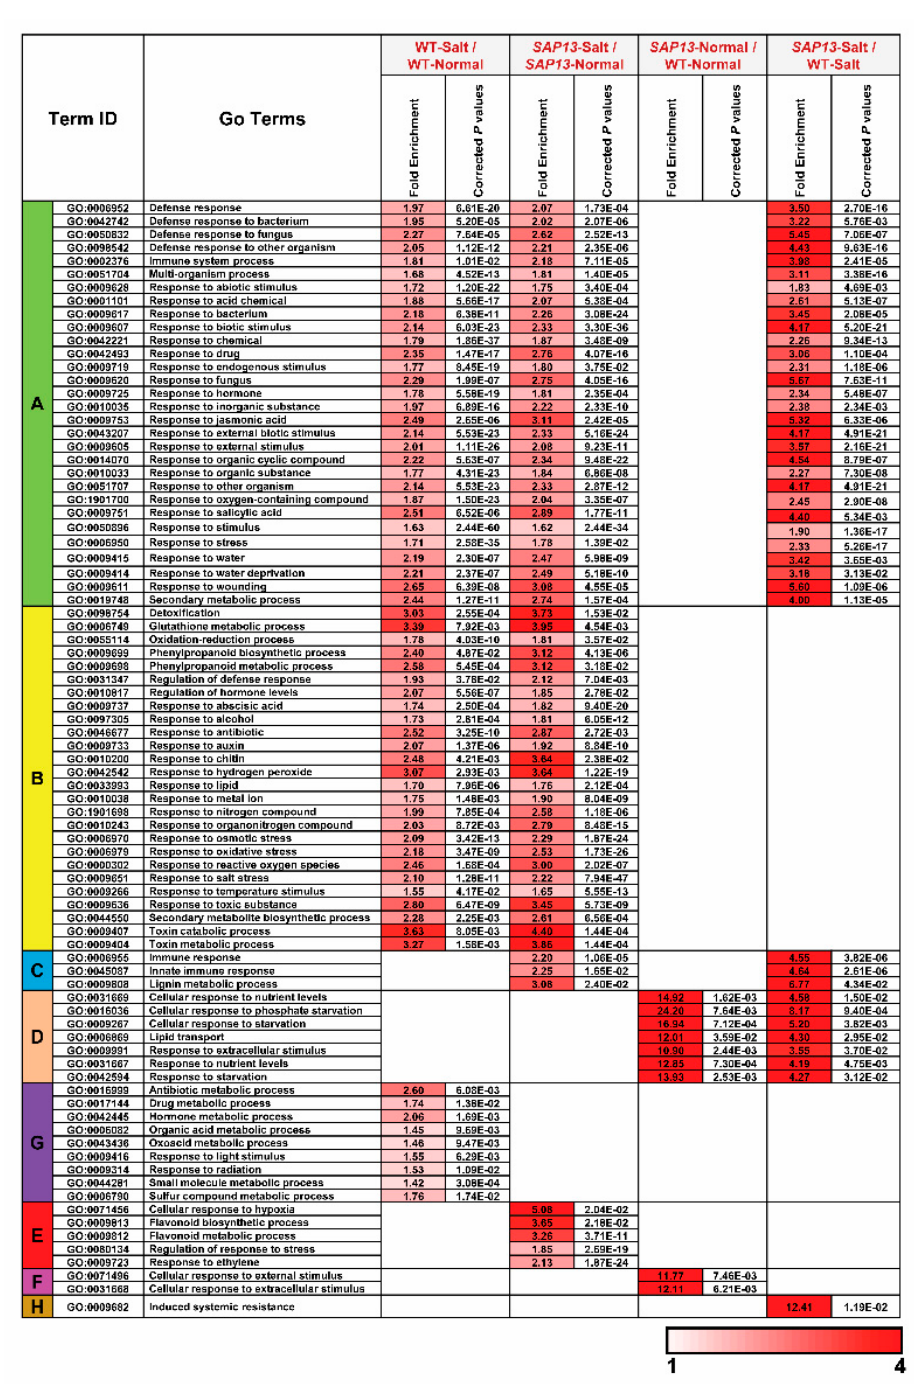
Figure 7. Biological processes in gene ontology (GO) enrichment analysis of all DEGs in four types of comparisons in WT and PtSAP13 -overexpressing plants. Only significantly enriched terms with corrected p -value < 0.05 are indicated.